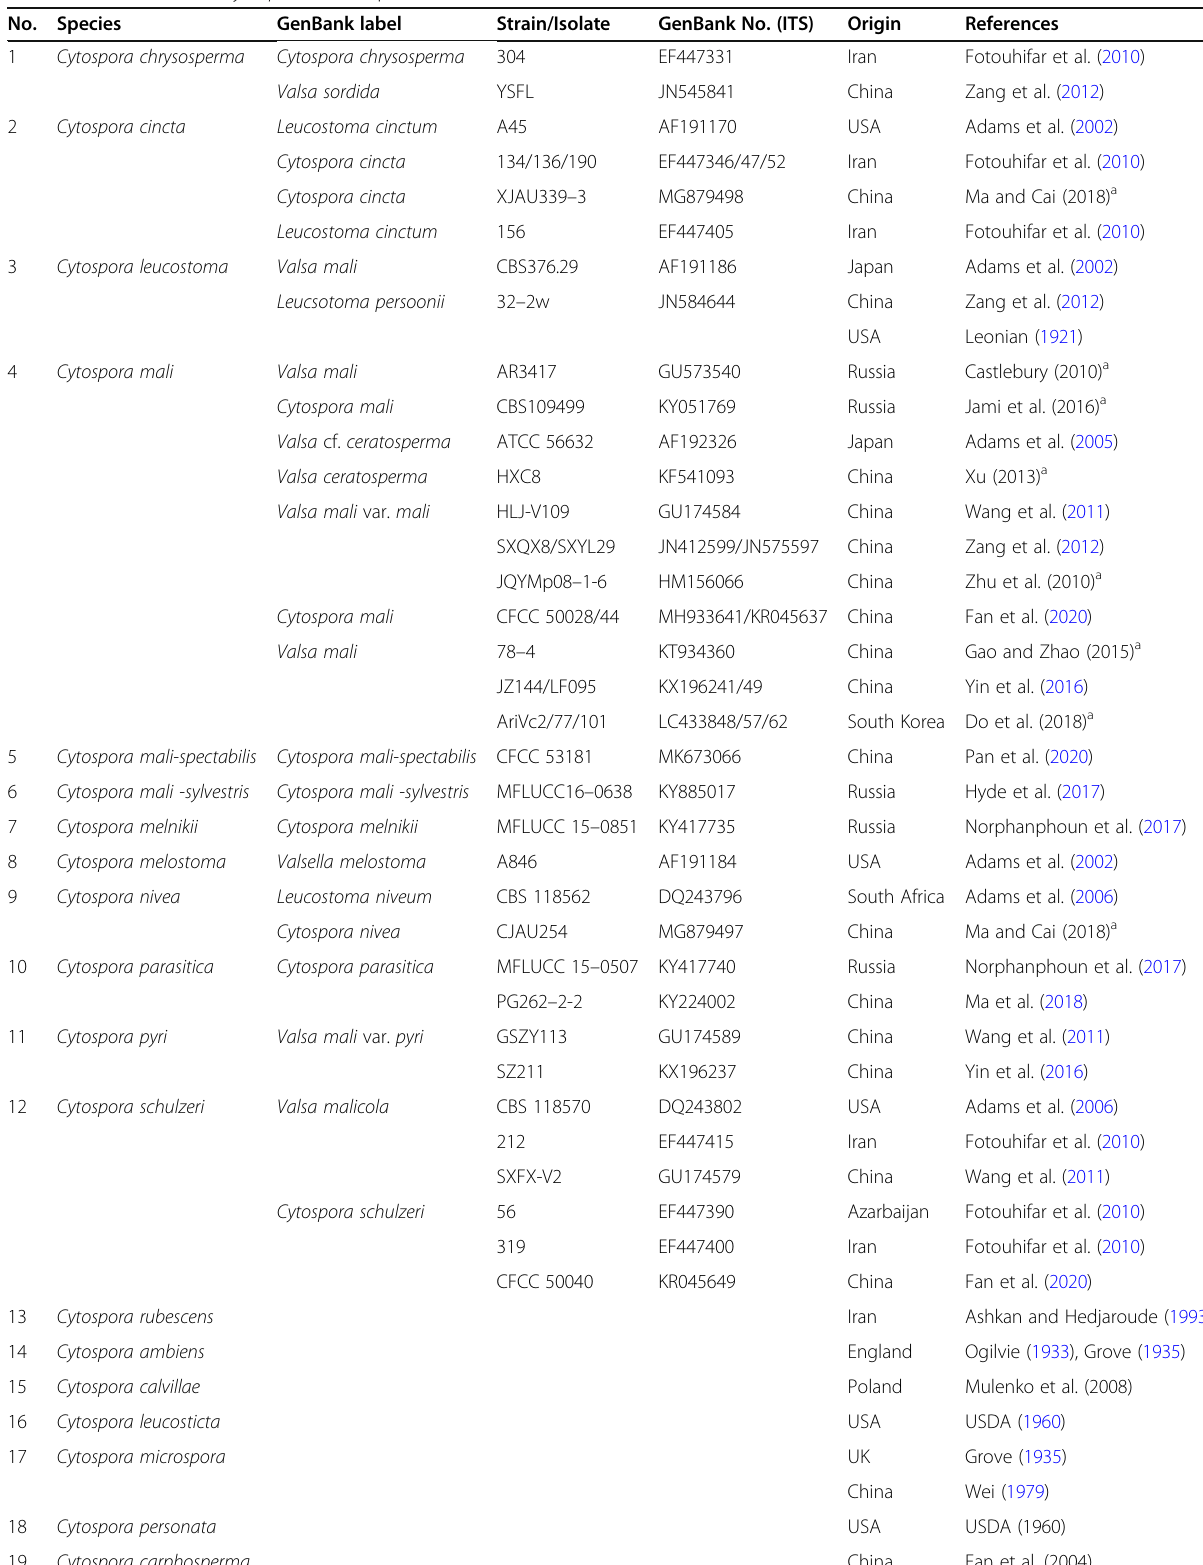
Table 1 Occurrence of Cytospora/Valsa species on Malus hosts No.